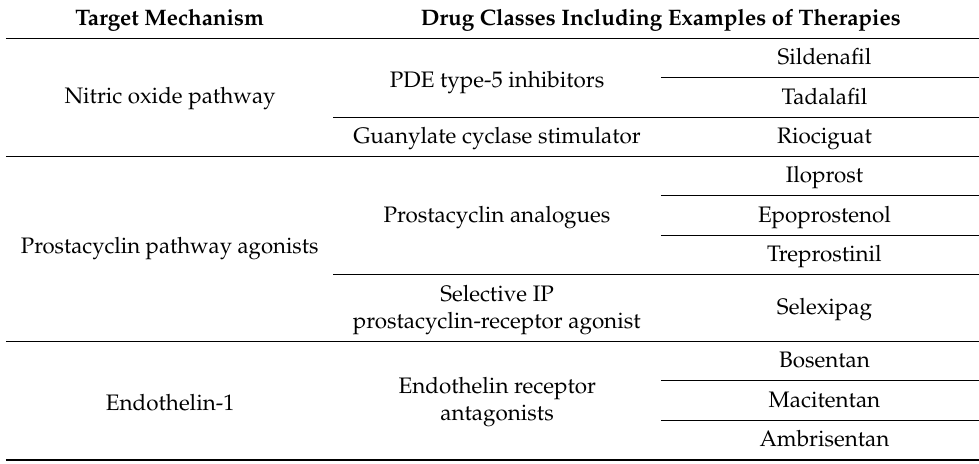
Table 3. Target mechanisms, drug classes and examples of therapies used for the treatment of